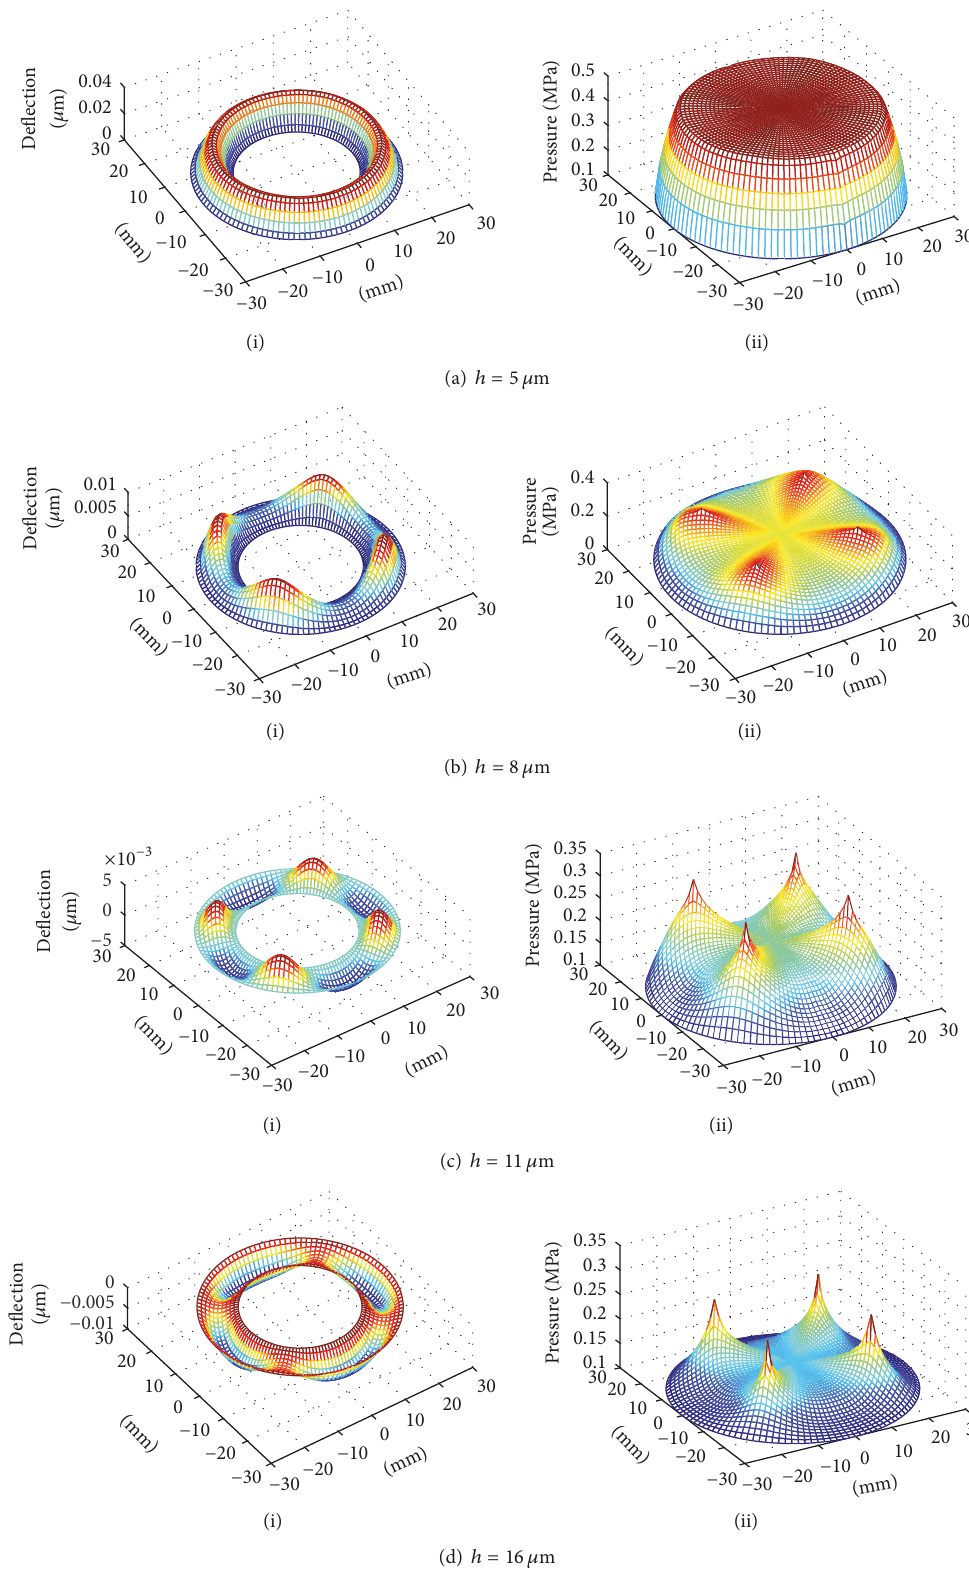
Figure 6: Diagram of (i) coupling deformation of EEPG and (ii) pressure